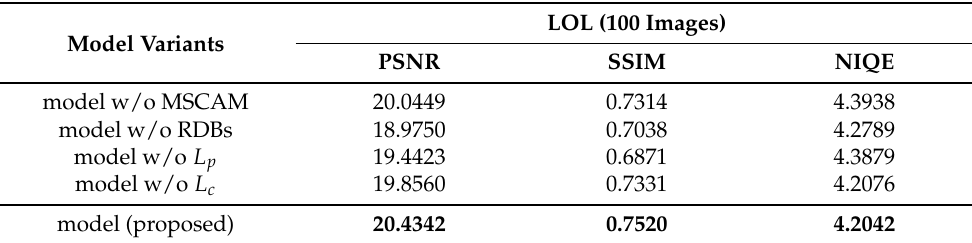
Table 3. Quantitative results of all ablation experiments on LOL testing set. The best results are highlighted in boldface. ‘w/o’ means without.